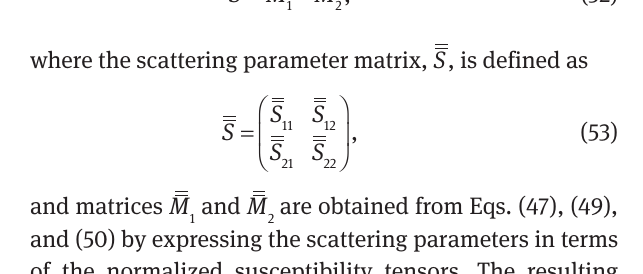
Figure 8: Full-wave simulation setup for the scattering parameter technique leading to the metasurface physical structure from the metasurface model based on Eq. (47). The unit cell is surrounded by PBCs and excited from ports 1 and